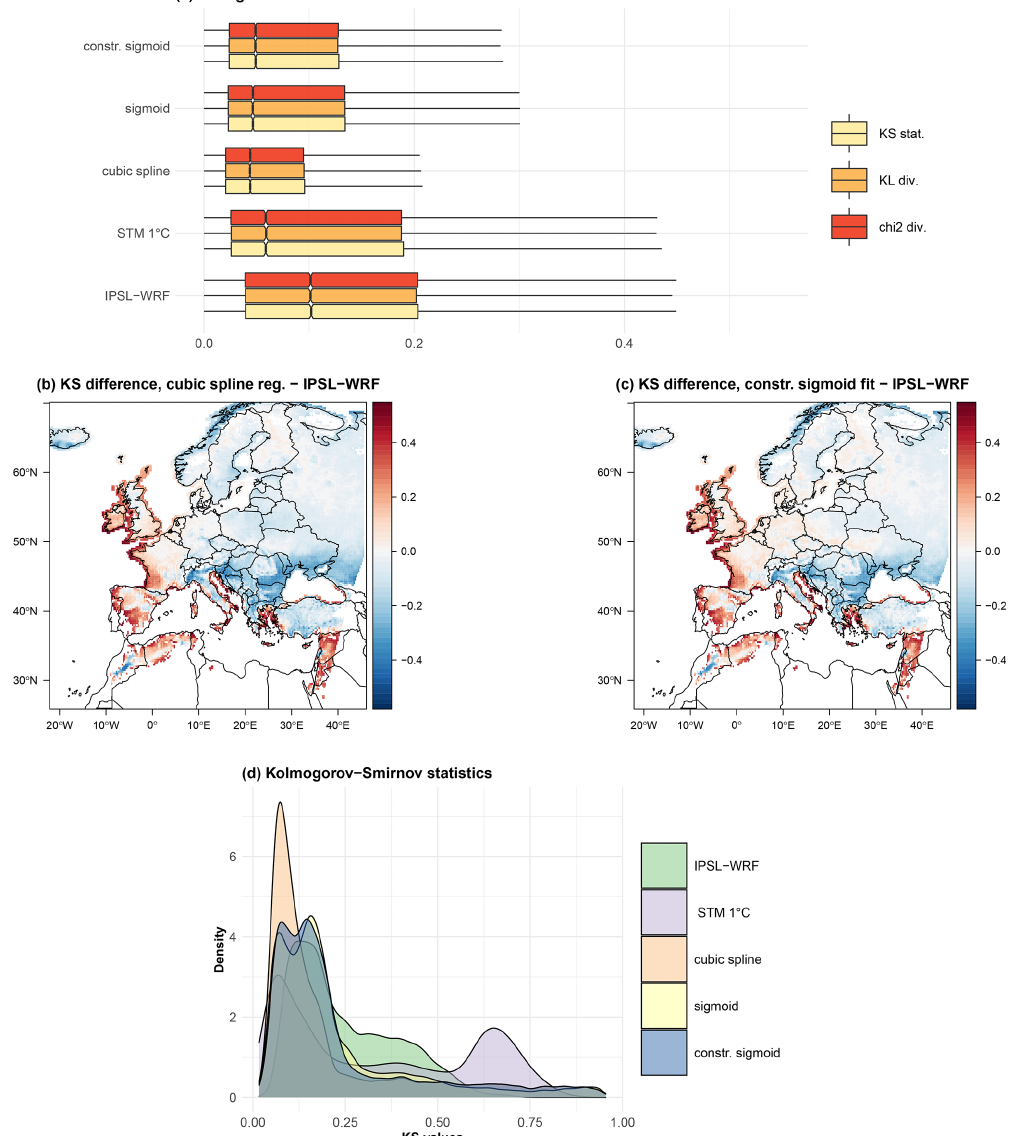
Figure 9. Performance of the statistical methods as bias correction methods of snowfall in terms of statistical divergences. Divergence measures box plots for statistical methods and raw IPSL_WRF simulations (a) . Maps of KS statistical differences between IPSL_WRF and spline regression (b) and constrained sigmoid fit (c) . Comparison of the probability density function of the KS statistics associated with the four considered statistical methods and the uncorrected IPSL_WRF model (d)